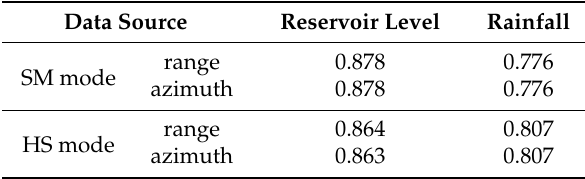
Table 3. The correlation between periodic deformation and reservoir level as well as